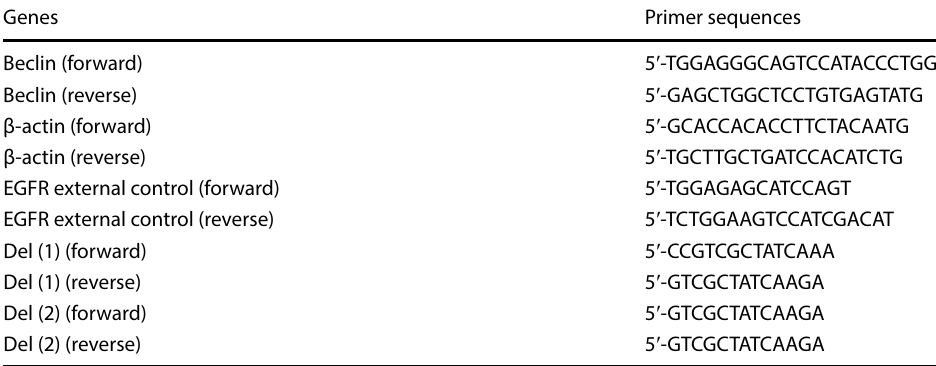
Table 1 Primers for